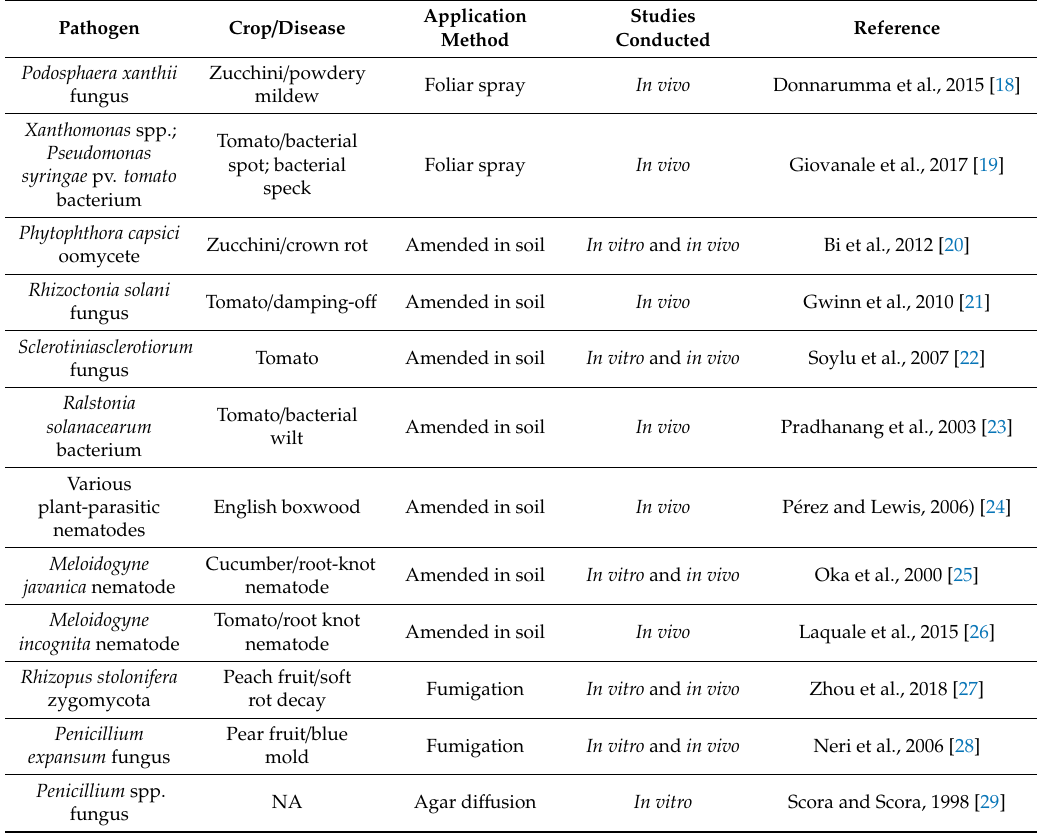
Table 1. Summary of studies on carvacrol or essential oils for control of plant